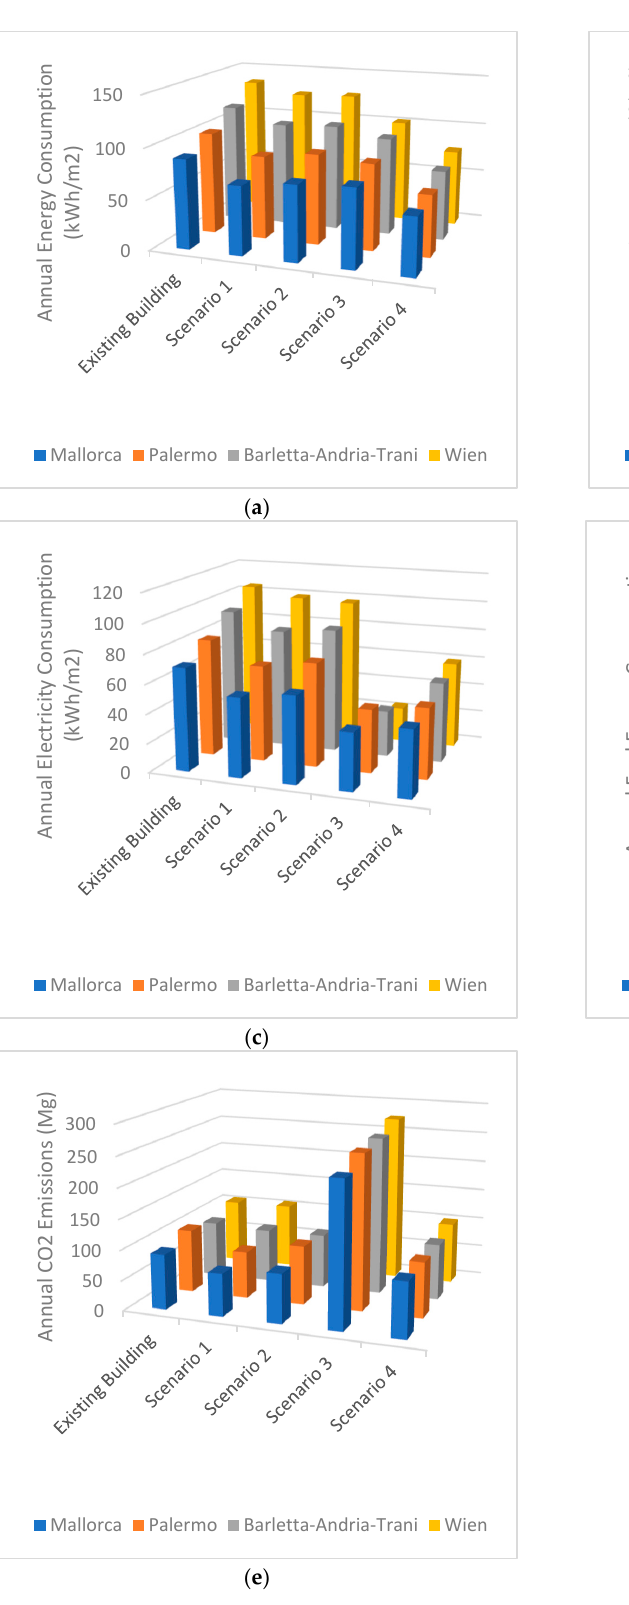
Figure 7. Diagrams of ( a ) Annual Energy Consumption (kWh/m 2 ), ( b ) Annual Energy Cost ( € /m 2 ), ( c ) Annual Electricity Consumption (kWh/m 2 ), ( d ) Annual Fuel Energy Consumption (kWh/m 2 ), ( e ) Annual CO 2 Emissions